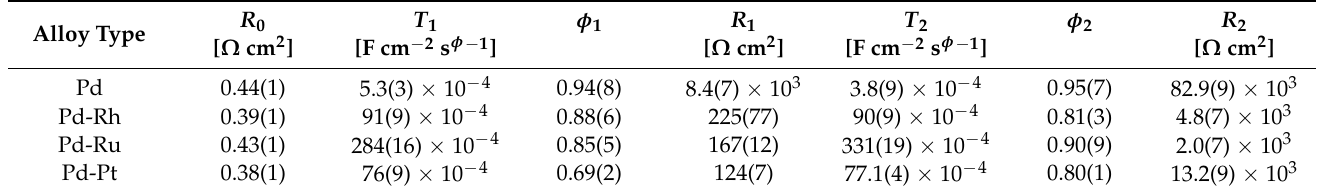
Table 5. The value of parameters obtained using the equivalent electrical circuit shown in Figure